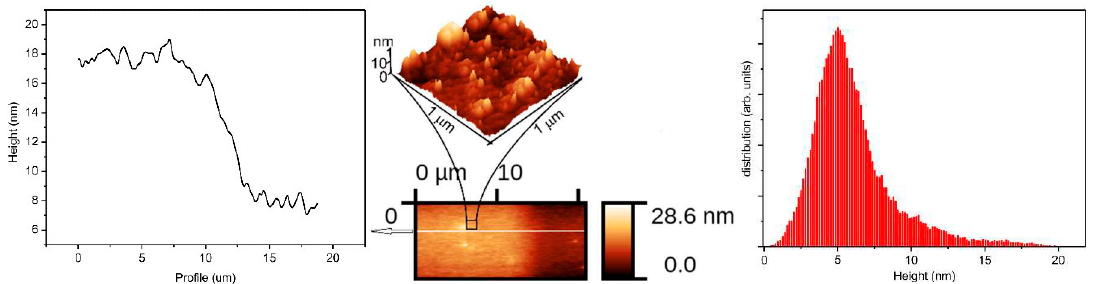
Figure 2. AFM data of RGVO SnO 2 nanolayers including the main image, average height distribution and the layer’s edge